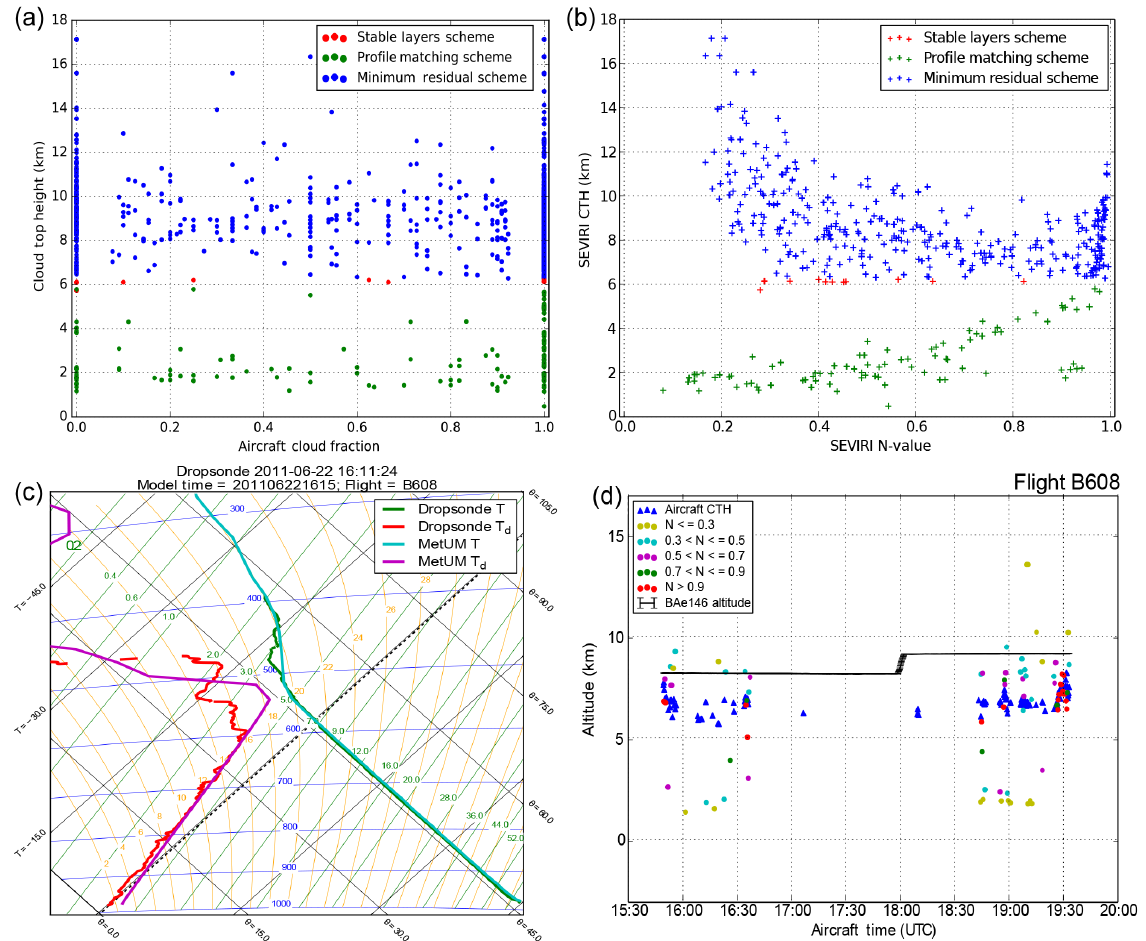
Figure 8. (a) Scatterplot of SEVIRI CTH plotted against aircraft cloud fraction (all flights); (b) SEVIRI CTH retrievals for every pixel associated with a BAe146 data point, plotted against the SEVIRI N -value, and streamed by the type of retrieval scheme used (all flights); (c) thermodynamic diagram of temperature and dew point from a dropsonde profile of the SABL from flight B608, overlaid with the nearest MetUM temperature profile; and (d) time series of lidar CTH (blue triangles) and SEVIRI CTH retrievals for B608. Pixels where cloud above the aircraft was detected have been omitted in each